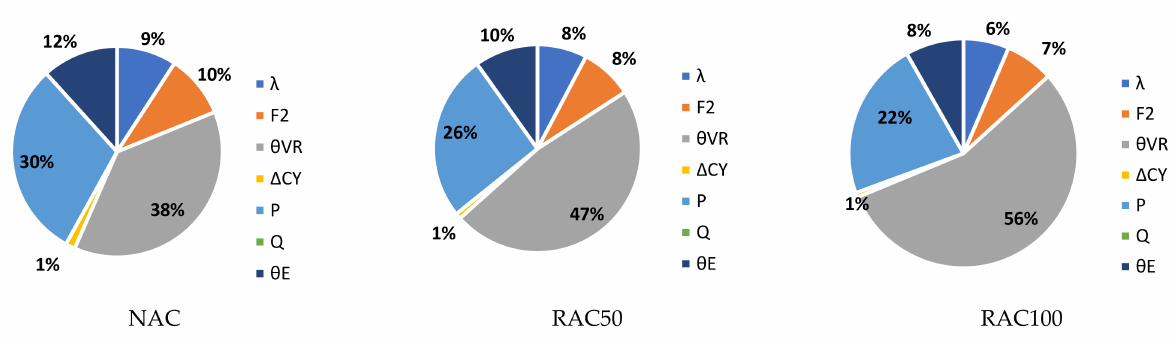
Figure 4. α 2 for χ = 0 and Slab 1 and the preliminary partial factors for shear design of elements without stirrups presented in Part 3. prEN1992 [32]. γ NAC = 1.40; γ C , V , RAC 50 = 1.60; γ C , V , RAC 50 = 1.70.